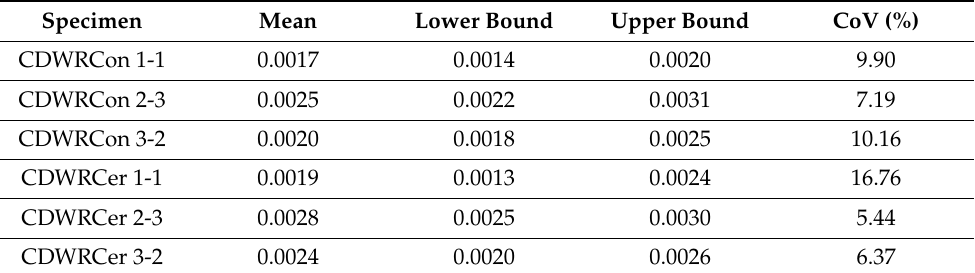
Table 6. Results obtained from the mechanical characterization of some specimens analysed by the 3D-DIC